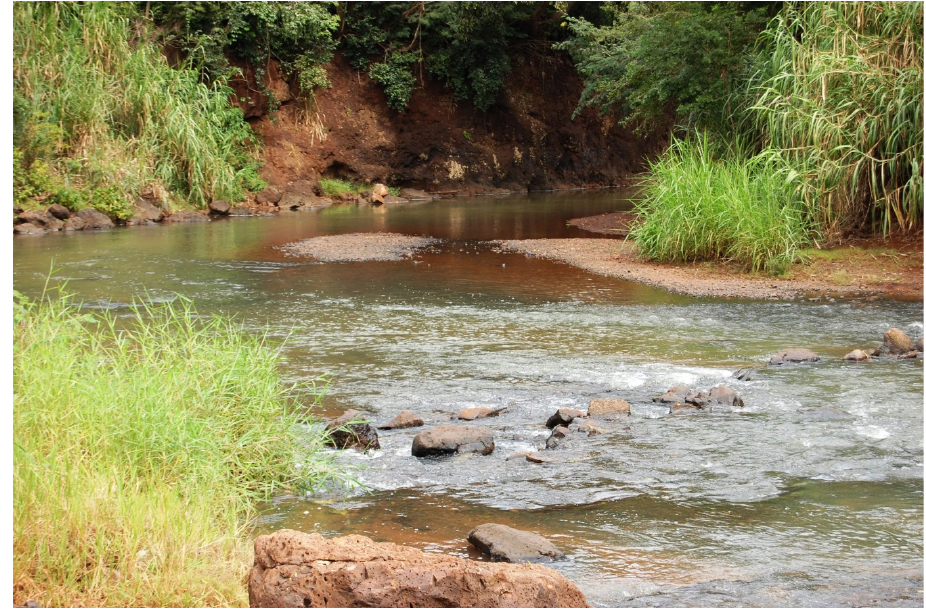
FIGURE 8 | Keller River, tributary of Ivaí River, Upper Paraná River basin. Brazil, Paraná State, Marialva. Type-locality of Hypostomus robertsoni